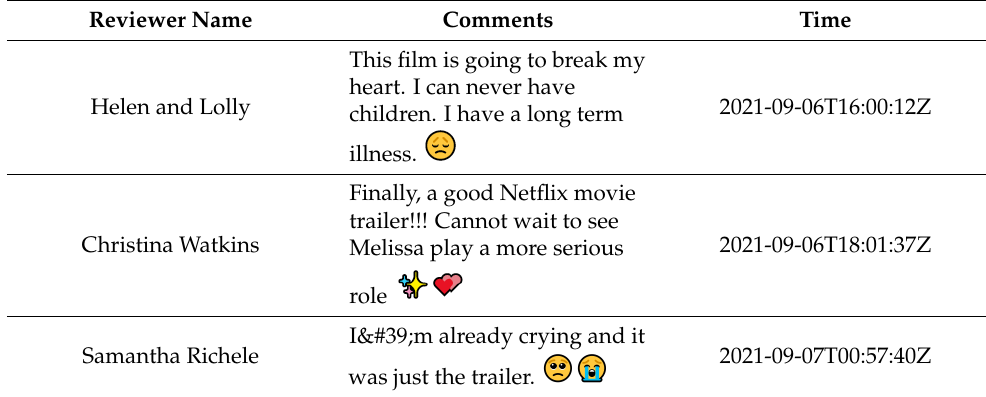
Table 1. Example of YouTube trailer review comments of the movie The Starling .